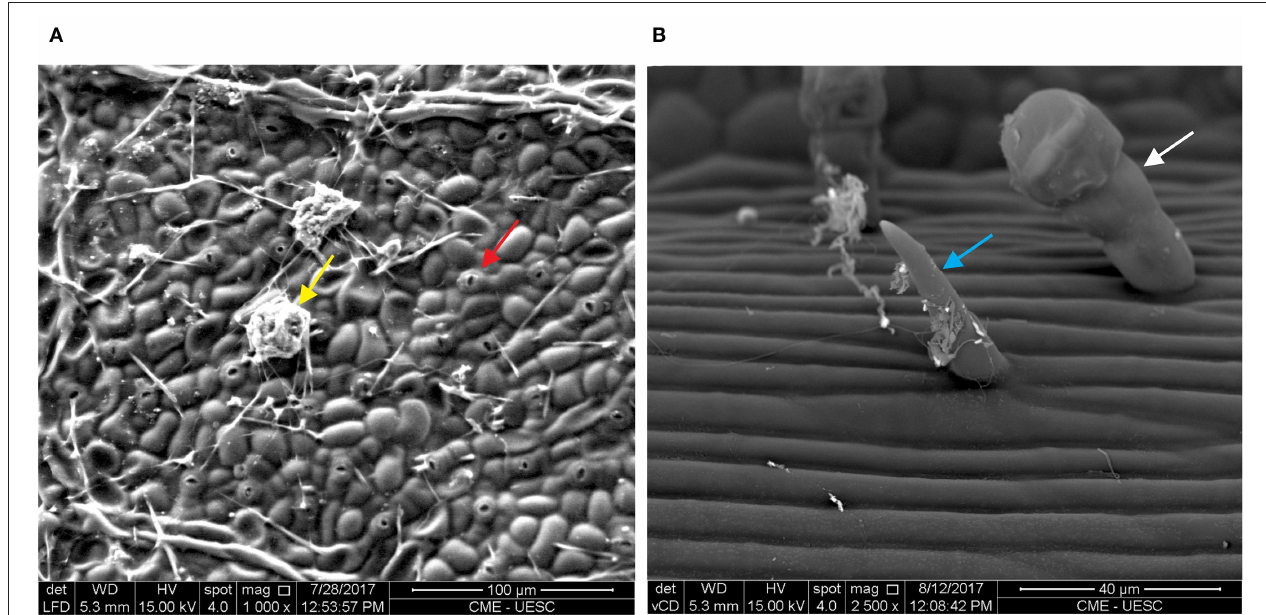
FIGURE 2 | Abaxial surface of Theobroma cacao leaf. (A) Stomata (red arrow) and adhered microorganisms of the phylloplane (yellow arrow). (B) Glandular (white arrow) and simple trichomes (blue